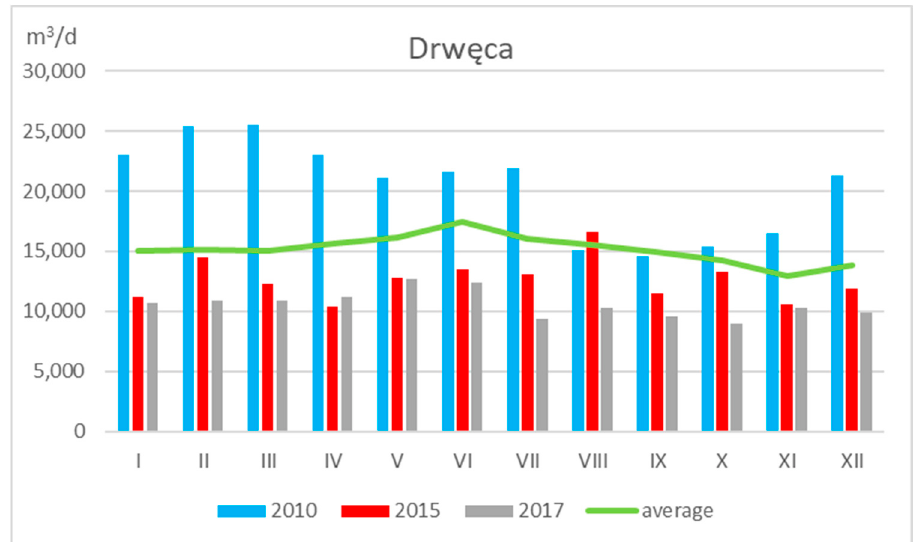
Figure 13. Monthly water abstraction level measured in m 3 /d from the Drw ę ca surface intake, shown for wet (2010), dry (2015), and average (2017) years.